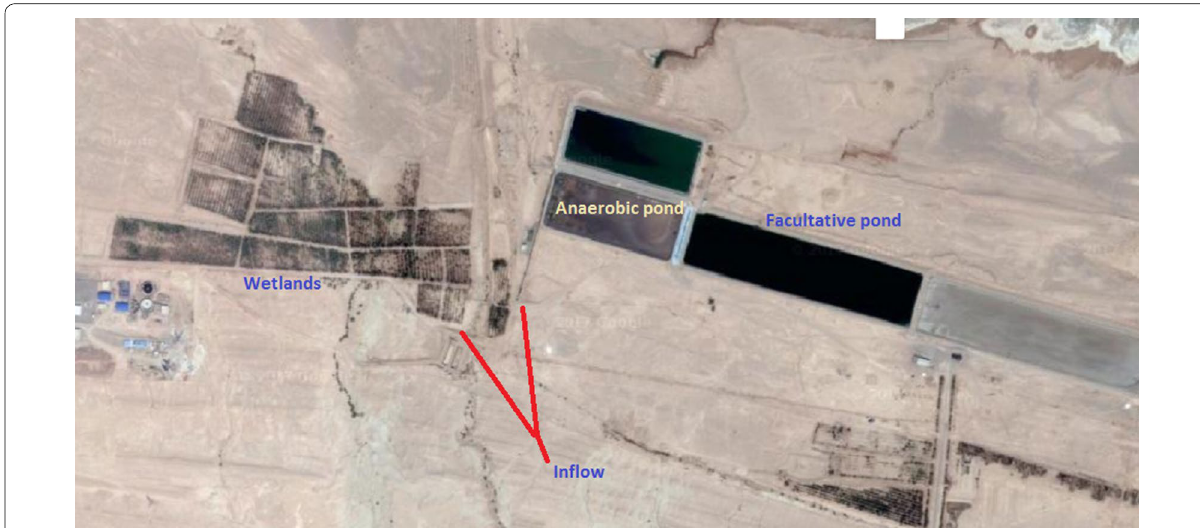
Fig. 1 The position of wastewater stabilized ponds (WSPs) and artificial wetlands of Yazd wastewater treatment